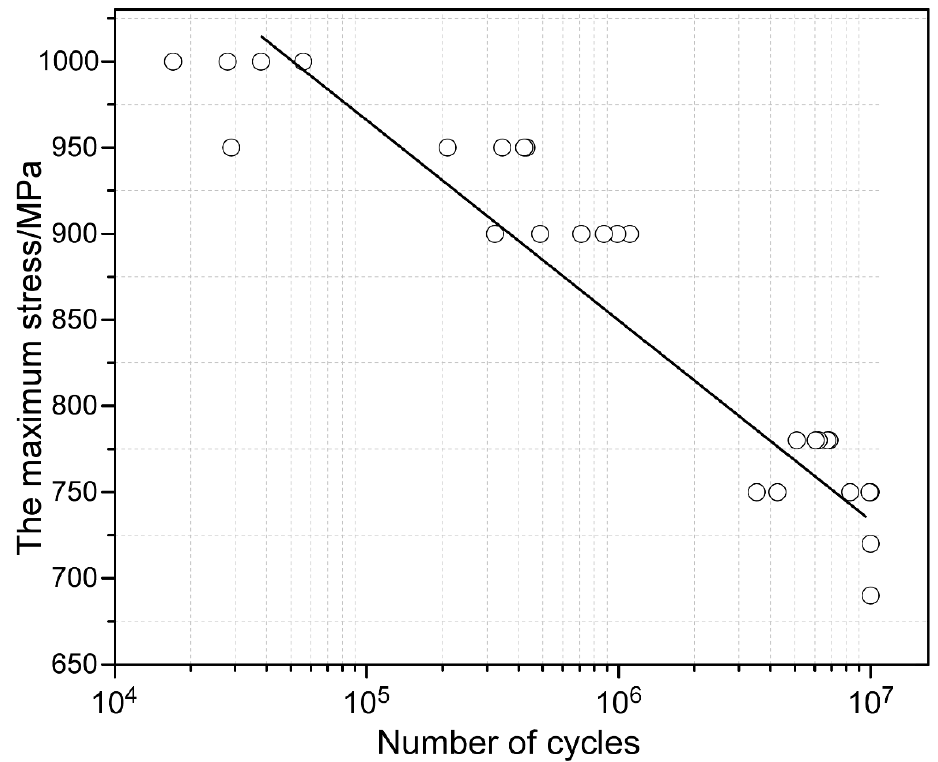
Figure 6. S-N curve of the Ti55511